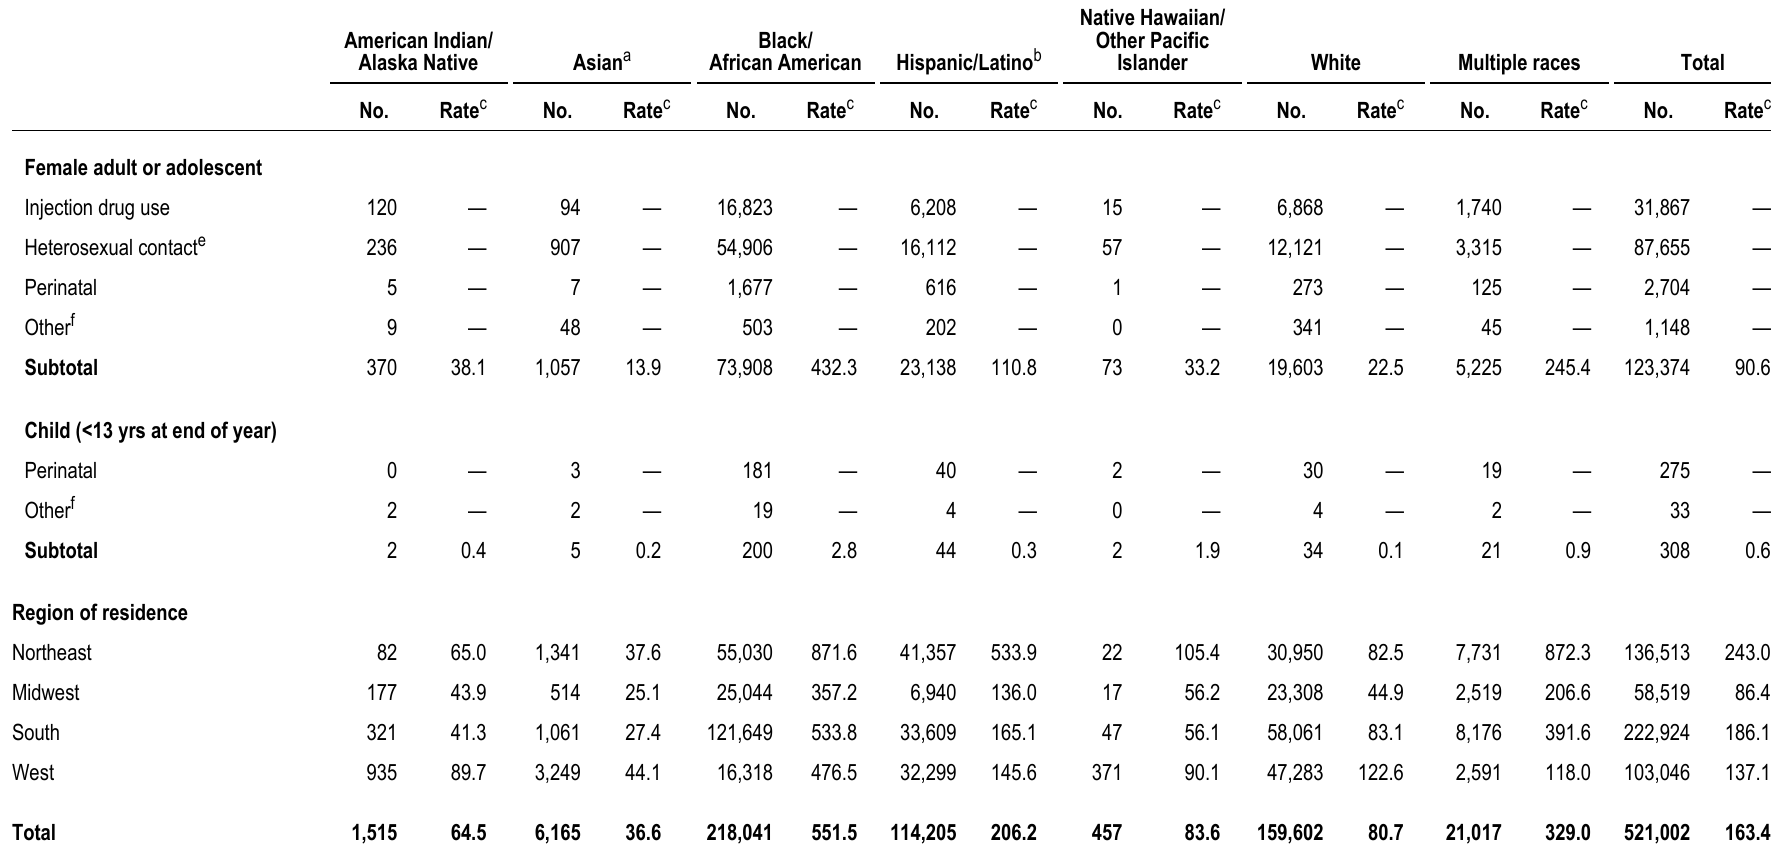
Table 21a. Persons living with diagnosed HIV infection ever classified as stage 3 (AIDS), by race/ethnicity and selected characteristics, year-end 2014—United States (cont) Native Hawaiian/ American Indian/ Black/ Other Pacific Alaska Native Asian a African American Hispanic/Latino b Islander White Multiple races Total No. Rate c No. Rate c No. Rate c No. Rate c No. Rate c No. Rate c No. Rate c No. Rate